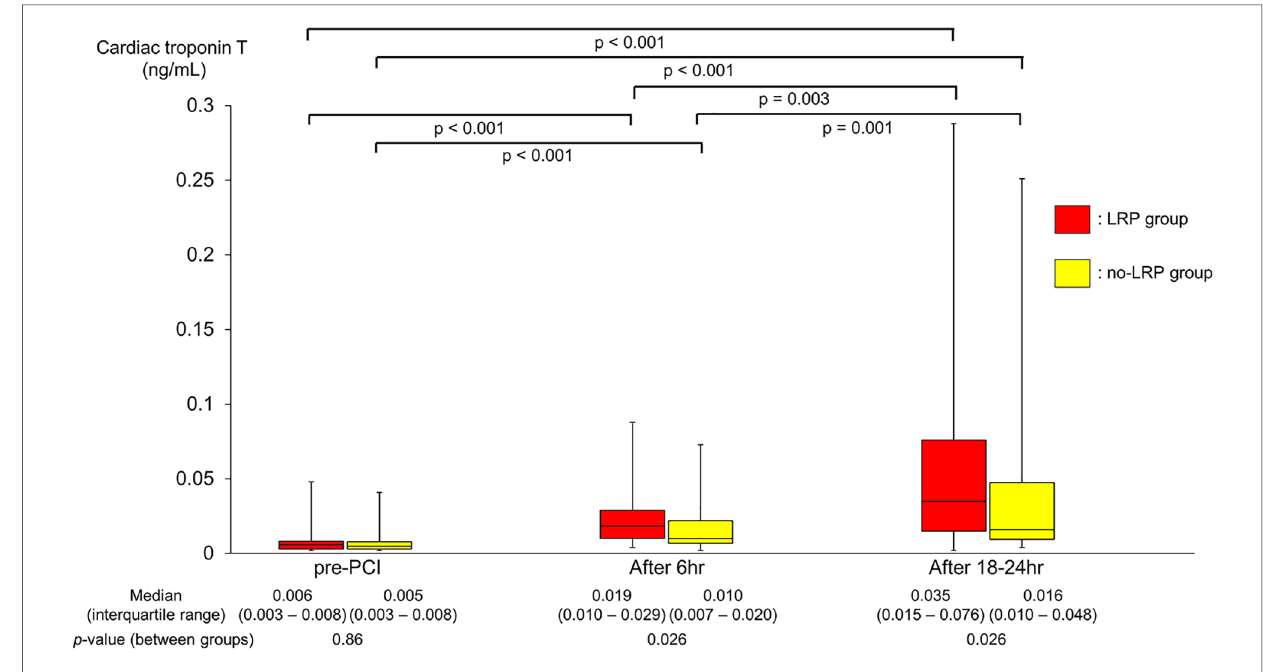
FIGURE 3 Changes in cTnT levels during PCI. cTnT, cardiac troponin T; PCI, percutaneous coronary intervention; LRP, lipid-rich